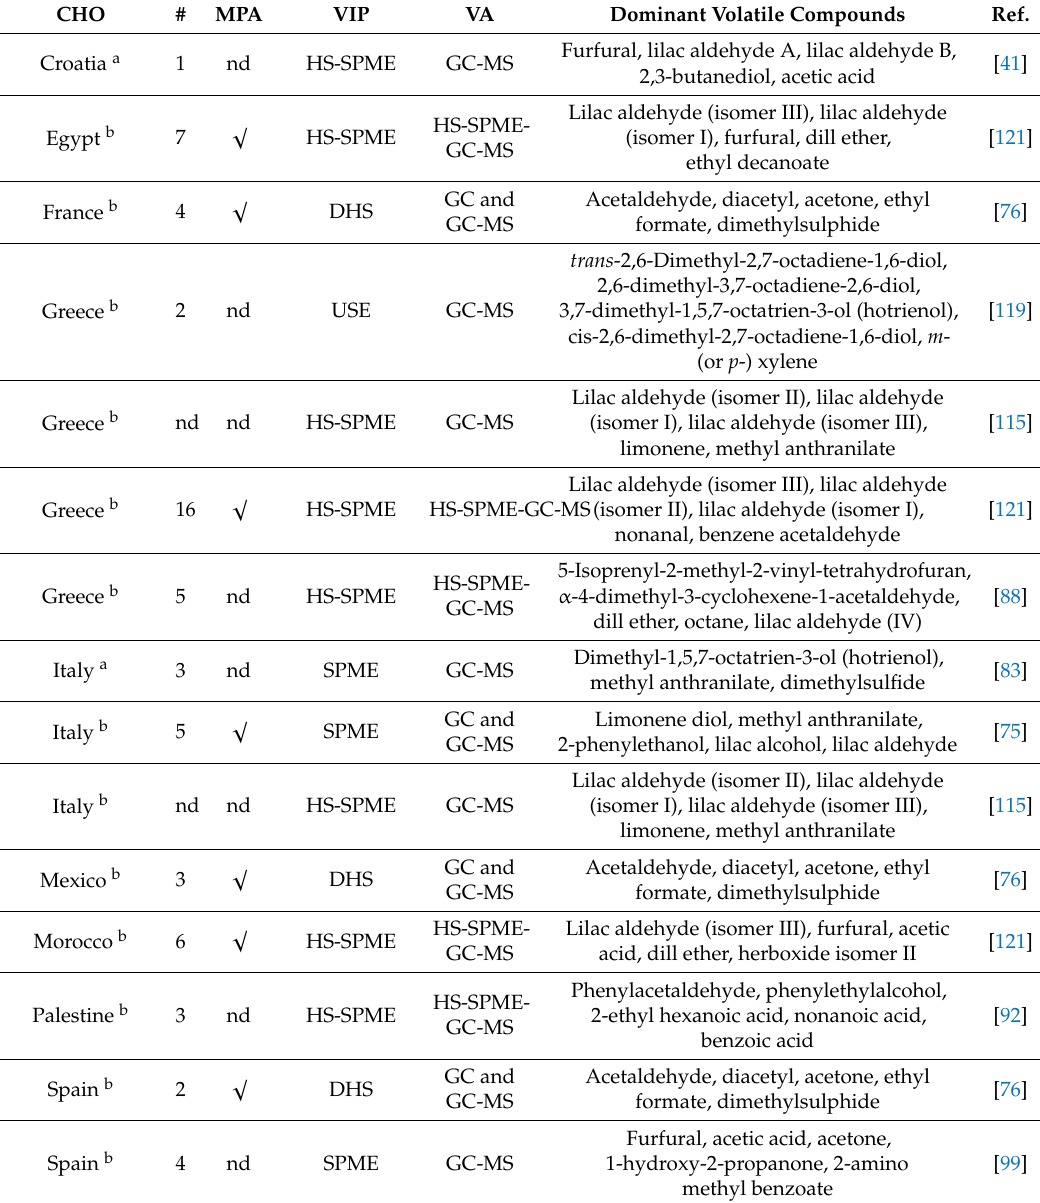
Table 13. Orange honey’s main volatiles, with reference to the country of origin, number of samples, isolation and analysis procedures and five main volatile components. Unless otherwise specified, the honeybee type was A. mellifera